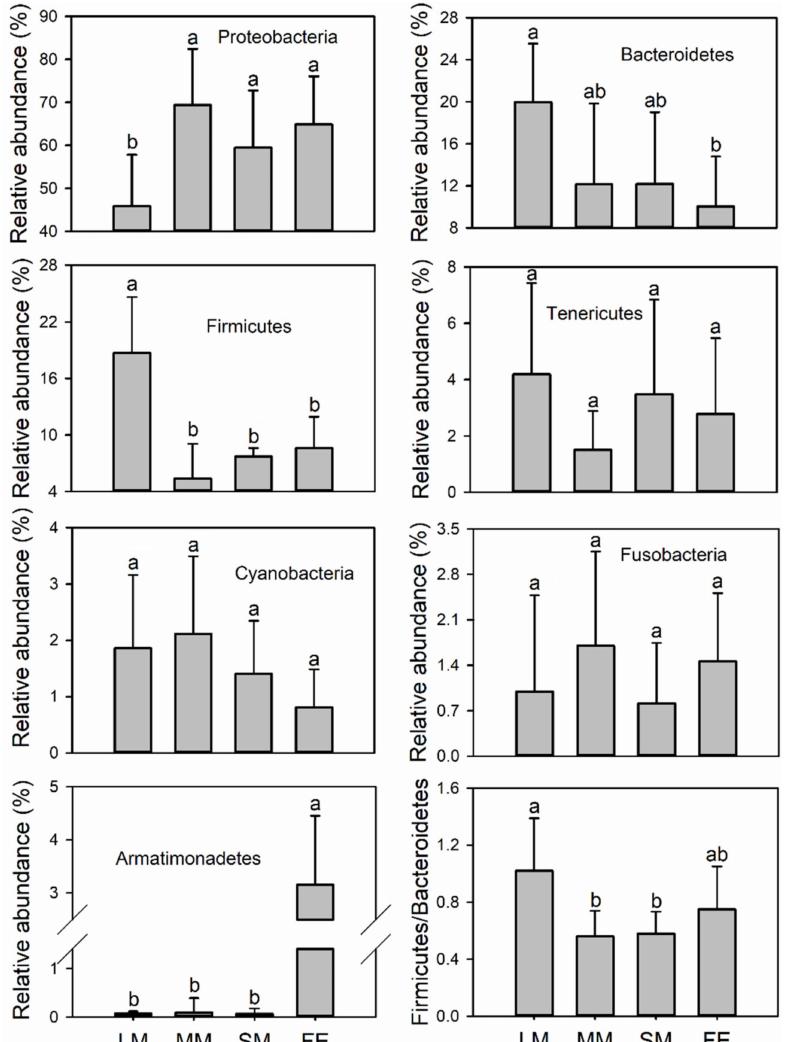
Figure 2. Relative abundances of dominant bacterial phyla of Odontolabis fallaciosa across treatments. Error bars denote standard deviation; di ff erent letters represent significant di ff erences from a one-way ANOVA with Tukey’s honestly significant di ff erence (HSD) post-hoc testing ( p < 0.05). LM: large male; MM: medium-sized male; SM: small male; FE: